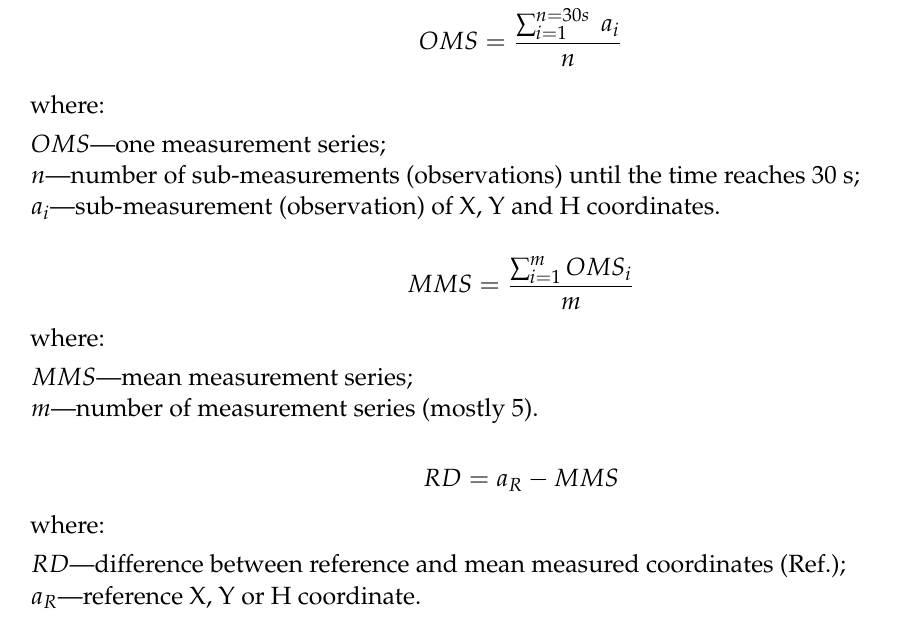
Figure 5. Block-chart of the experiment. The collected observations in one 30-s measurement series were averaged (Equation (1)). After measuring with each antenna in at least 5 series (Equation (2)), the results were taken for further analysis. The differences from the reference coordinates (Equation (3)) and standard deviations of the measured coordinates (Equation (4)) were calculated for each station and each hardware configuration.